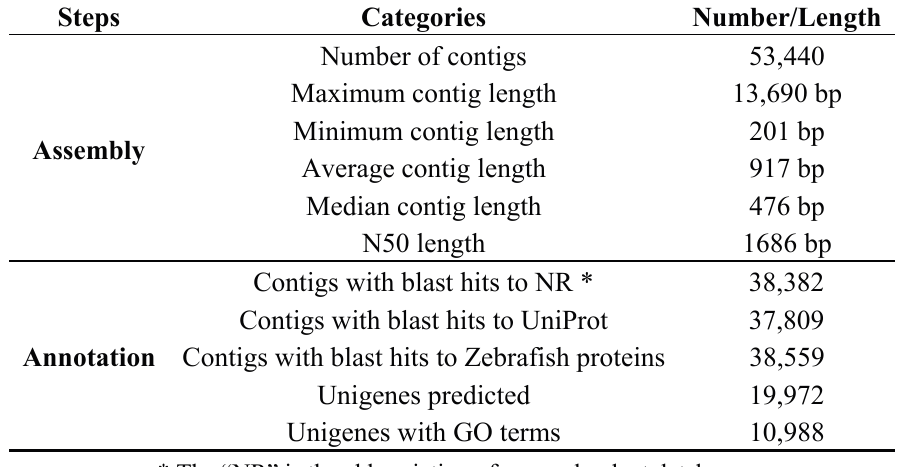
Table 2. Transcriptome reference assembly and annotation statistics.